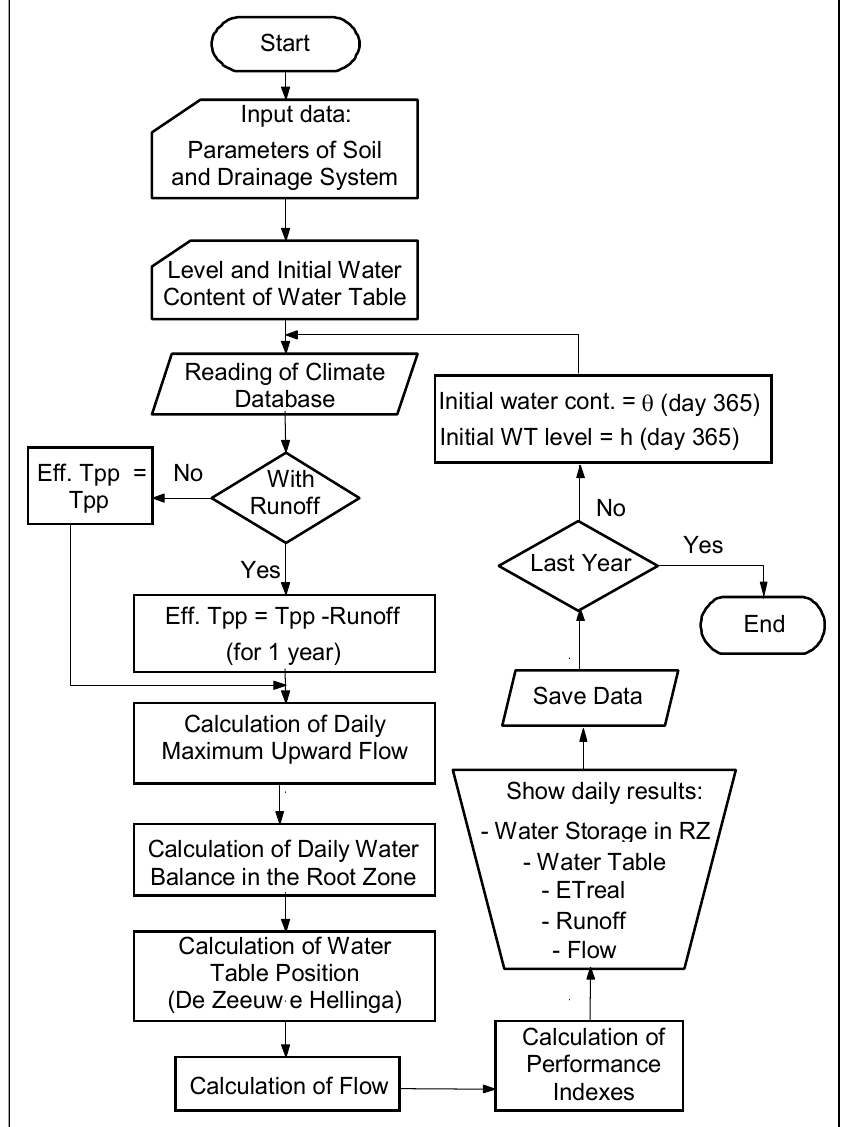
Figure 3. Flowchart of the proposed model.